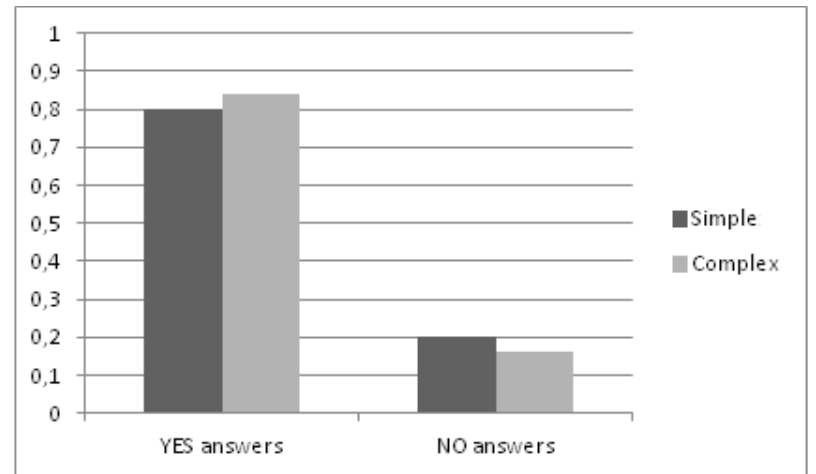
Figure 13 . Proportion between YES and NO answers for complement sentences: Effect of the syntactic complexity of the wh